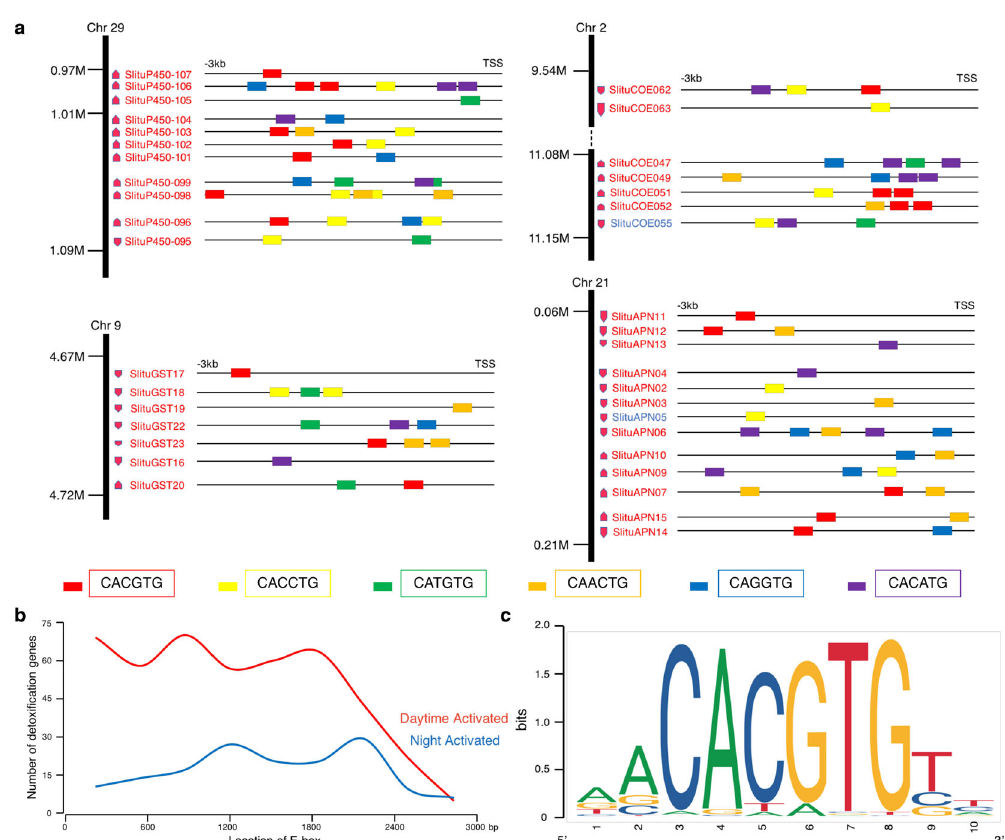
Fig. 5 E-box annotation and location in the regulatory region of detoxi fi cation genes. a Location of multiple E-boxes in the regulatory regions of clustered detoxi fi cation genes. Different types of E-boxes are annotated 3 kb upstream from transcriptional start sites (TSS) and shown with different colored rectangles. Daytime activated detoxi fi cation genes (red) and night activated detoxi fi cation genes (blue) are shown for a given cluster. b The number of detoxi fi cation genes relative to the distance between the E-box sequence and the TSS. c Annotated motifs of canonical E-boxes recognized by speci fi c transcription